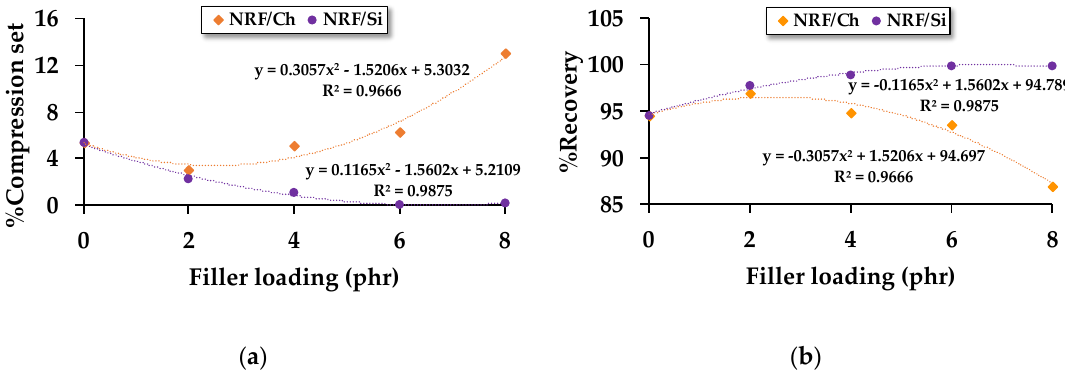
Figure 5. Compression recovery properties of the NRFs: ( a ) %compression set of the NRF with different filler loadings; ( b ) %recovery of the NRF with different filler loadings.